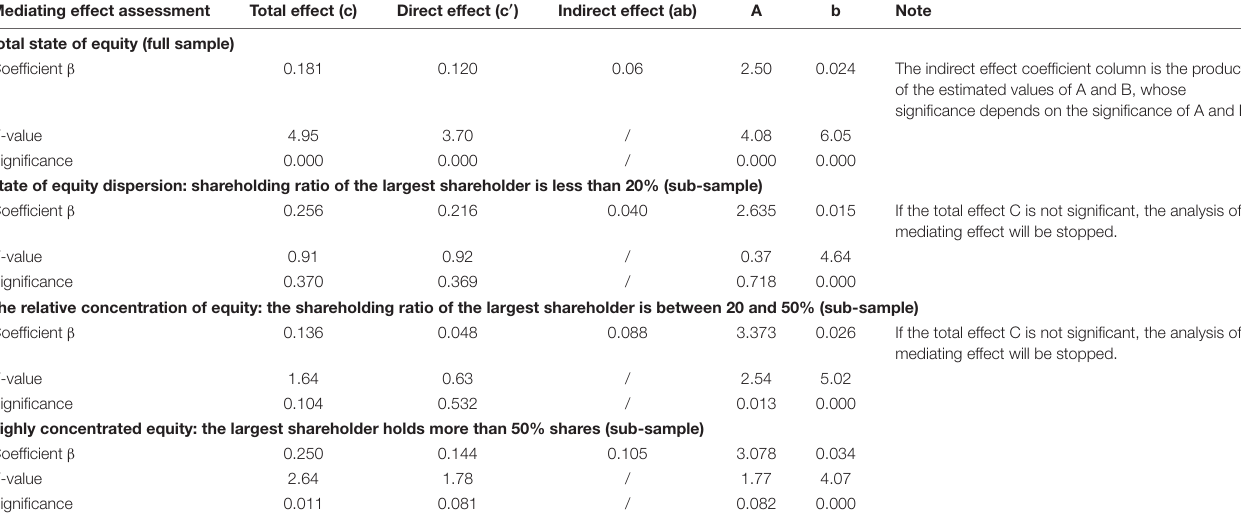
TABLE 6 | Regression results of mediating effect.